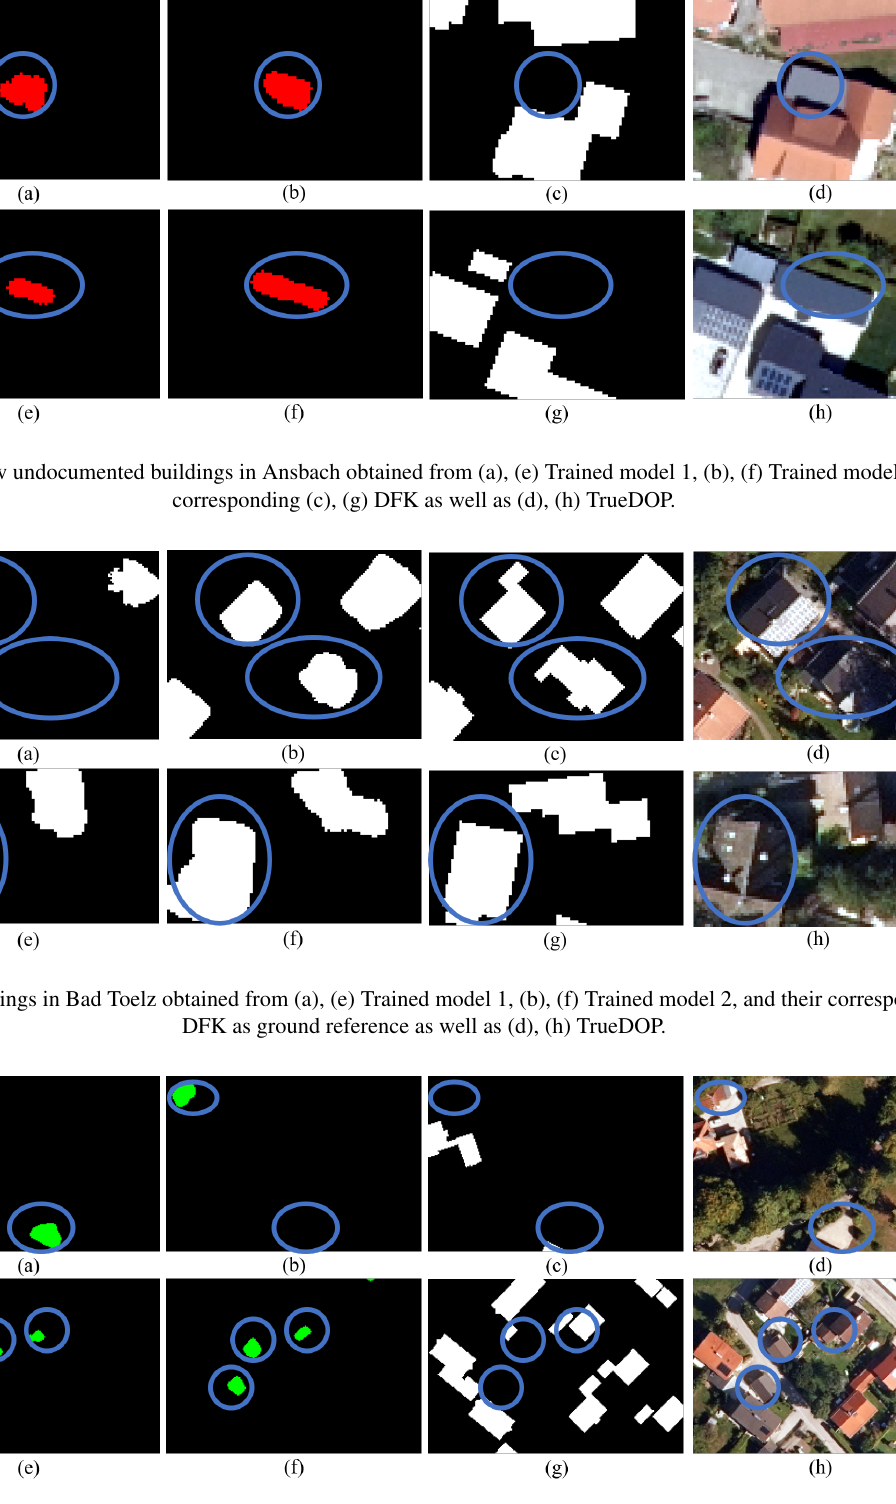
Figure 8. The new undocumented buildings in Bad Toelz obtained from (a), (e) Trained model 1, (b), (f) Trained model 2, and their corresponding (c), (g) DFK as well as (d), (h)